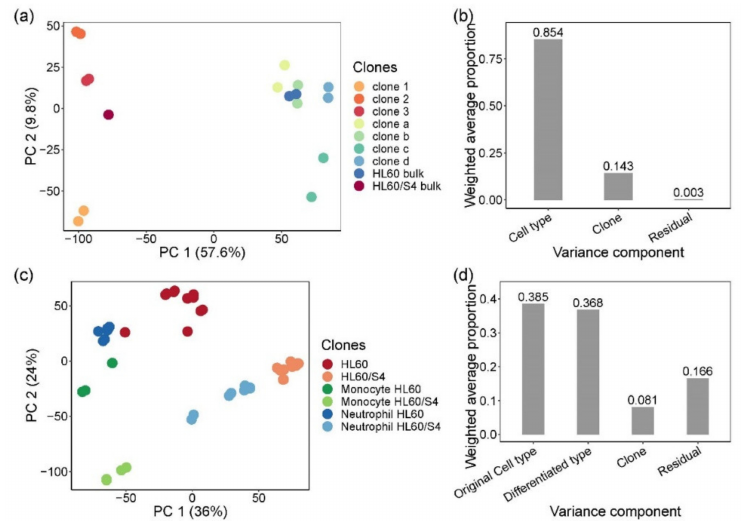
Figure 1. Heterogeneity of gene expression in single-cell clones and myeloid lineage differentiated clones. ( a ) Principal component analysis (PCA) of bulk RNA sequencing of parental single-cell clones and bulk cells. PCA was performed on a normalized log2 CPM count expression matrix of 17 samples from HL60- and HL60 / S4-generated single-cell clones. Each dot represents 17 samples, two biological replicates for each clone and bulk, except for HL60 / S4 bulk. Samples are colored by clones: warm color dots are samples from HL60 / S4 cell lines, while cold color dots are samples from HL60 cell lines. PC1 separated samples by cell type, explaining 57.6% of the total variation. PC2 separated samples by clones, representing 9.8% of the total variation. ( b ) Principal variance component analysis showed the weighted average proportion of each variance component—cell type (85.4%), clone (14.3%), and residual (0.3%)—all of which explained variance captured by the first five principal components (86.8% of total variance). The majority of the total expression variance of single-cell clones was explained by cell type and clone variance components. ( c ) Principal component analysis of bulk RNA sequencing of myeloid lineage differentiated clones, performed by normalized log2 counts per million (CPM) expression matrix. Each dot represents 47 samples from differentiated monocytes and neutrophils and undifferentiated control cells, two biological replicates for each stimulation on each clone. Clone d was excluded due to sequencing error. Samples are colored by cell type and differentiation lineages: monocytes are green, neutrophils are blue, and control cells are red. To distinguish the original cell type of each sample, HL60 cells are dark colors, and HL60 / S4 cells are light colors. ( d ) Principal variance component analysis showed the weighted average proportion of each variance component—original cell type (38.5%), differentiated type (36.8%), clone (8.1%), and residual (16.6%)—all of which explained variance captured by the first five principal components (83.9% of total variance). The 16.6% of unexplained variance might be from the variance of biological replicates and cultural differences between two